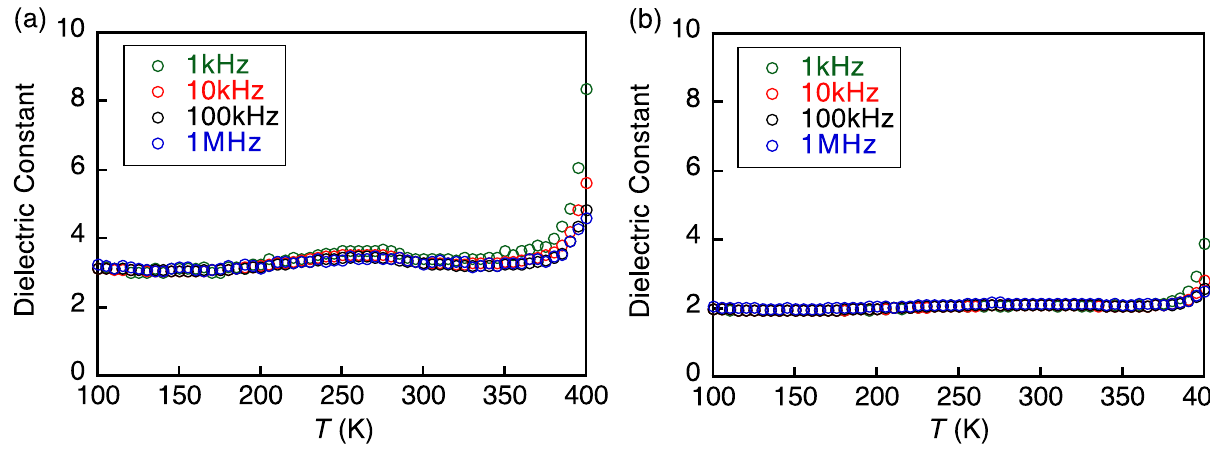
Figure 5. Dielectric properties of the coordination polymers 1a ( a ) and 1b ( b ) estimated from the impedance